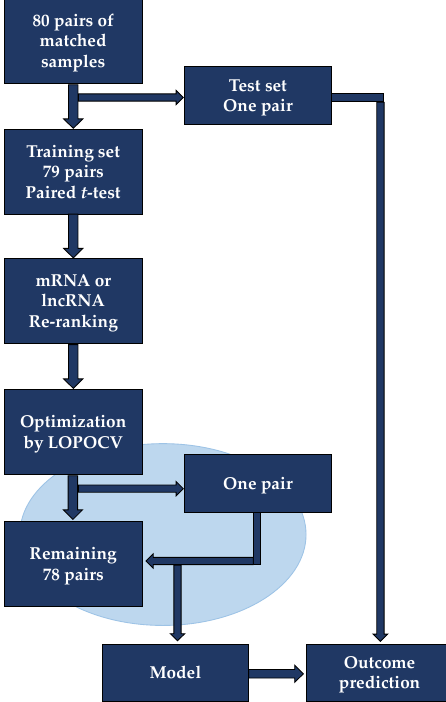
Figure A1. Outcome prediction using leave-one-pair-out cross-validation. In this procedure, a single pair of matched samples served as test samples while the remaining 79 sample pairs served as a training set. For feature selection in the training set, Student’s two-tailed t -test was used to identify differentially expressed mRNAs and lncRNAs (FDR ≤ 0.05) where these subsequently were re-ranked according to their random forest-based variable importance value. Using leave-one-out- cross-validation (LOPOCV), each of the seven machine learning methods identified the optimal mRNA and lncRNA set by using the highest ranked mRNAs/ lncRNAs in a top-down forward- wrapper approach where outcome in one selected pair was predicted using the remaining 78 pairs as training set (inner loop, blue). The inner loop procedure was repeated until each pair had been left out once. The final optimal mRNA or lncRNA set was used to predict outcome in the initially left out test pair. The entire procedure was repeated until all pairs had been left out as a test pair and their outcome independently predicted by the inner training